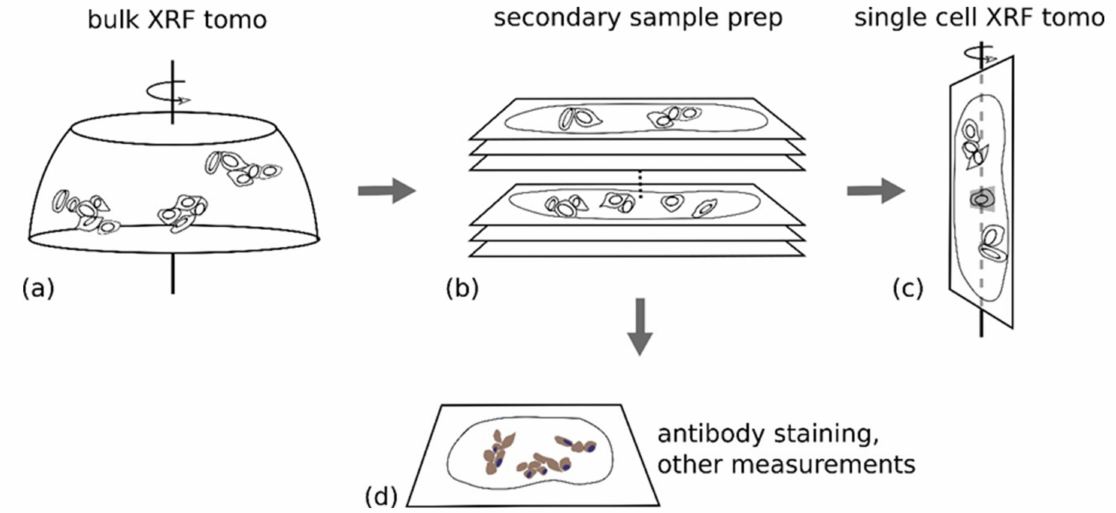
Figure 5. Schematic showing the workflow of multiscale tomography. ( a ) Paraffin embedded cell clusters supported on Ultralene thin film were examined by performing XRF tomography with coarse resolution; ( b ) The sample was sectioned into a series of 5 µ m thick slices; ( c ) A single cell (highlighted in gray) on one of the thin sections was again examined by performing XRF tomography, but with fine resolution (80 nm pixel size for 2D projections); ( d ) Antibody staining was performed on other thin slices, which were then imaged using visible light. This served a dual purpose of confirming that IHC after XFM of the bulk imaged sample is possible and to generate a 3D model of the cell cluster so that we can establish the position of the single cell imaged in ( c ) inside the entire cluster imaged in ( a